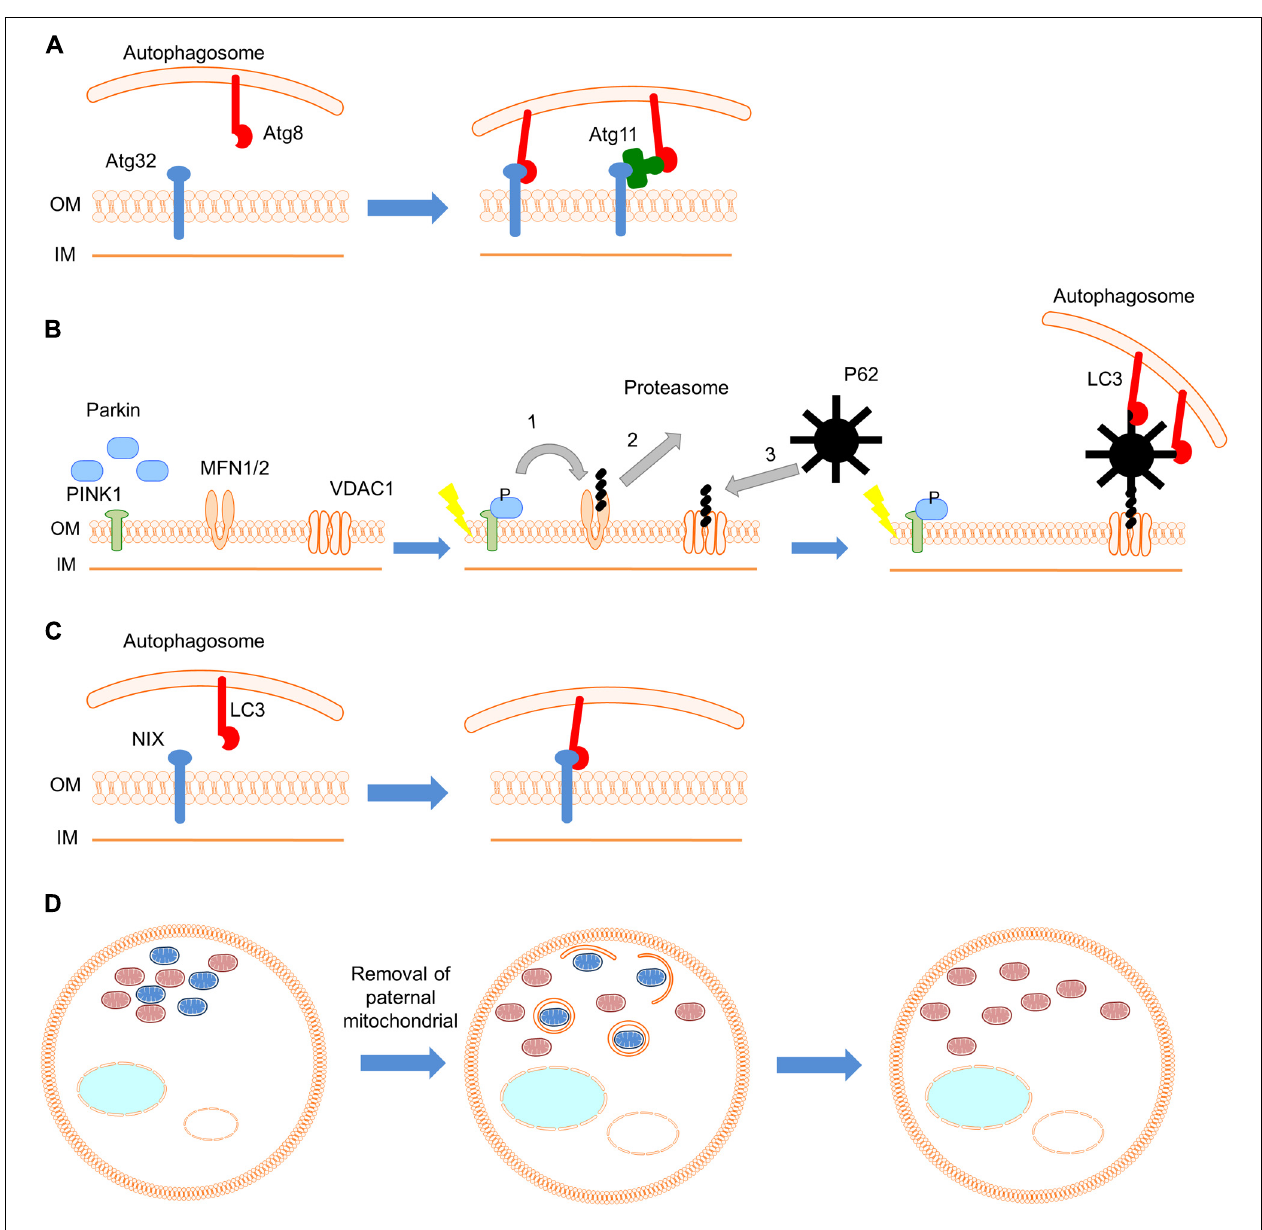
(blue; oocyte-derived mitochondria are shown in pink). (D) Upon mitochondrial depolarization, PINK1 (green) is stabilized on the outer mitochondrial membrane. Subsequently, Parkin (blue) is recruited and ubiquitylates outer mitochondrial membrane proteins such as MFN1/2 andVDAC1. (1) Ubiquitinated MFN1/2 is degraded by the proteasome system. Damaged mitochondria are isolated and cannot fuse with the healthy mitochondrial population. (2) Next, ubiquitin-binding adaptor molecules, such as p62 (black), are recruited to mitochondria to initiate mitophagy through their interaction with LC3